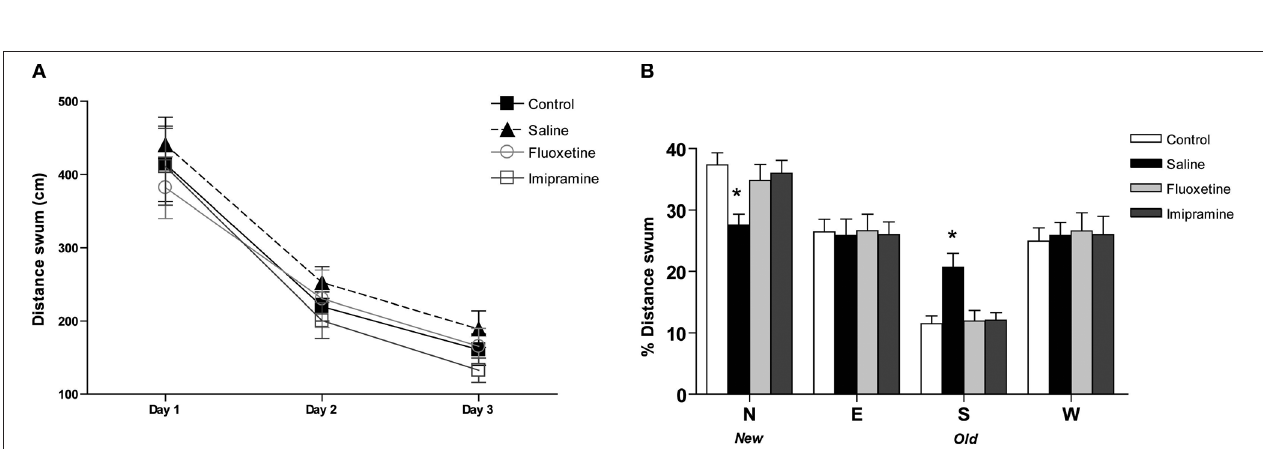
FIGURE 1 | Behavioral effects of uCMS and antidepressant treatment on mood and anxiety domains. (A) Sucrose preference in the SCTs performed during uCMS. (B) Immobility time in the FST, (C) percentage of time spent in the open arms of the EPM and (D) latency time to feed in the NSF paradigm. * P < 0.005. Data presented as mean ± s.e.m.